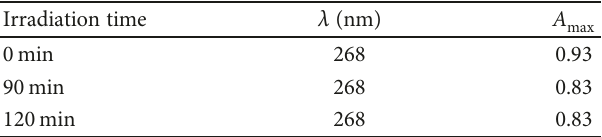
Figure 6: Absorption spectrum of A. pavonina galactomannan at a concentration of 0.25% ( w / v ) before and after UV irradiation. Table 2: Absorbance values at maximum peaks of the UV-vis spectrum for galactomannan samples after di ff erent irradiation times.